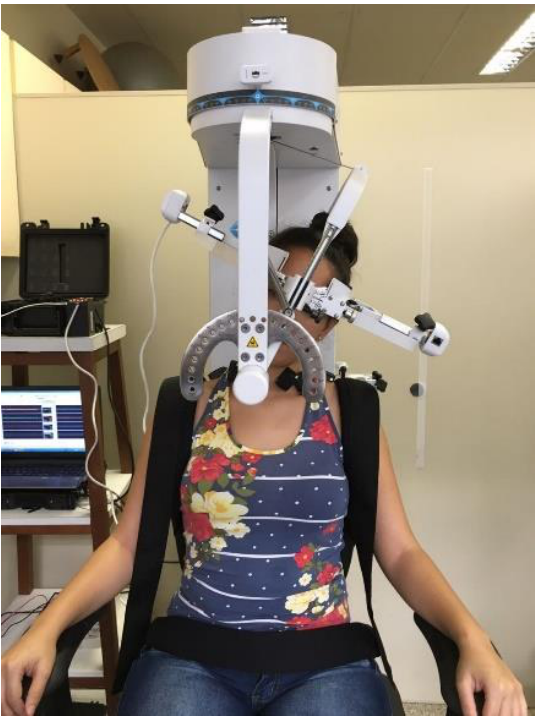
Figure 1. Representation of a participant’s position and stabilization on the Multi-Cervical Rehabilitation Unit (MCU).